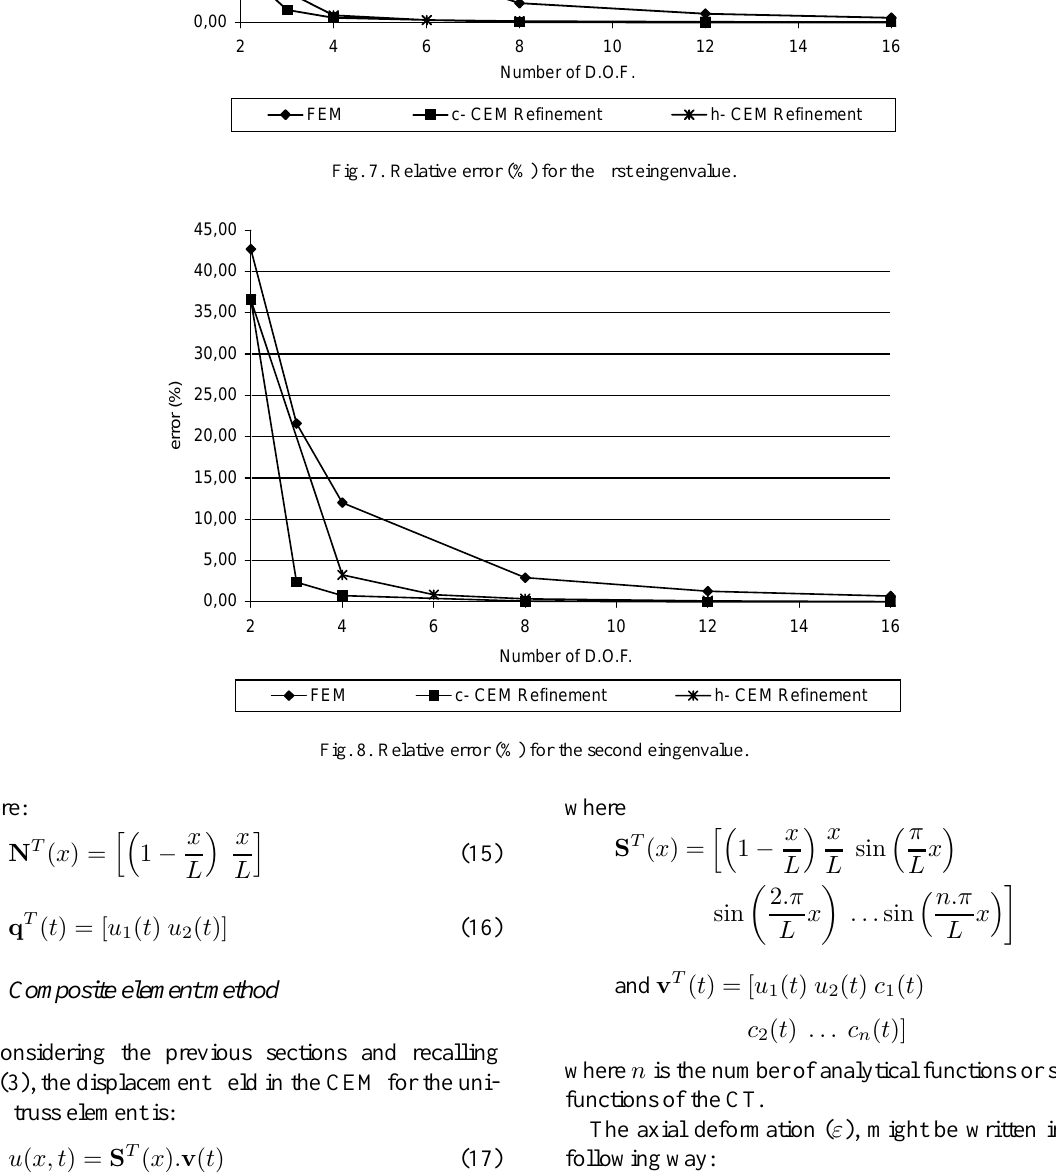
Number of D.O.F.